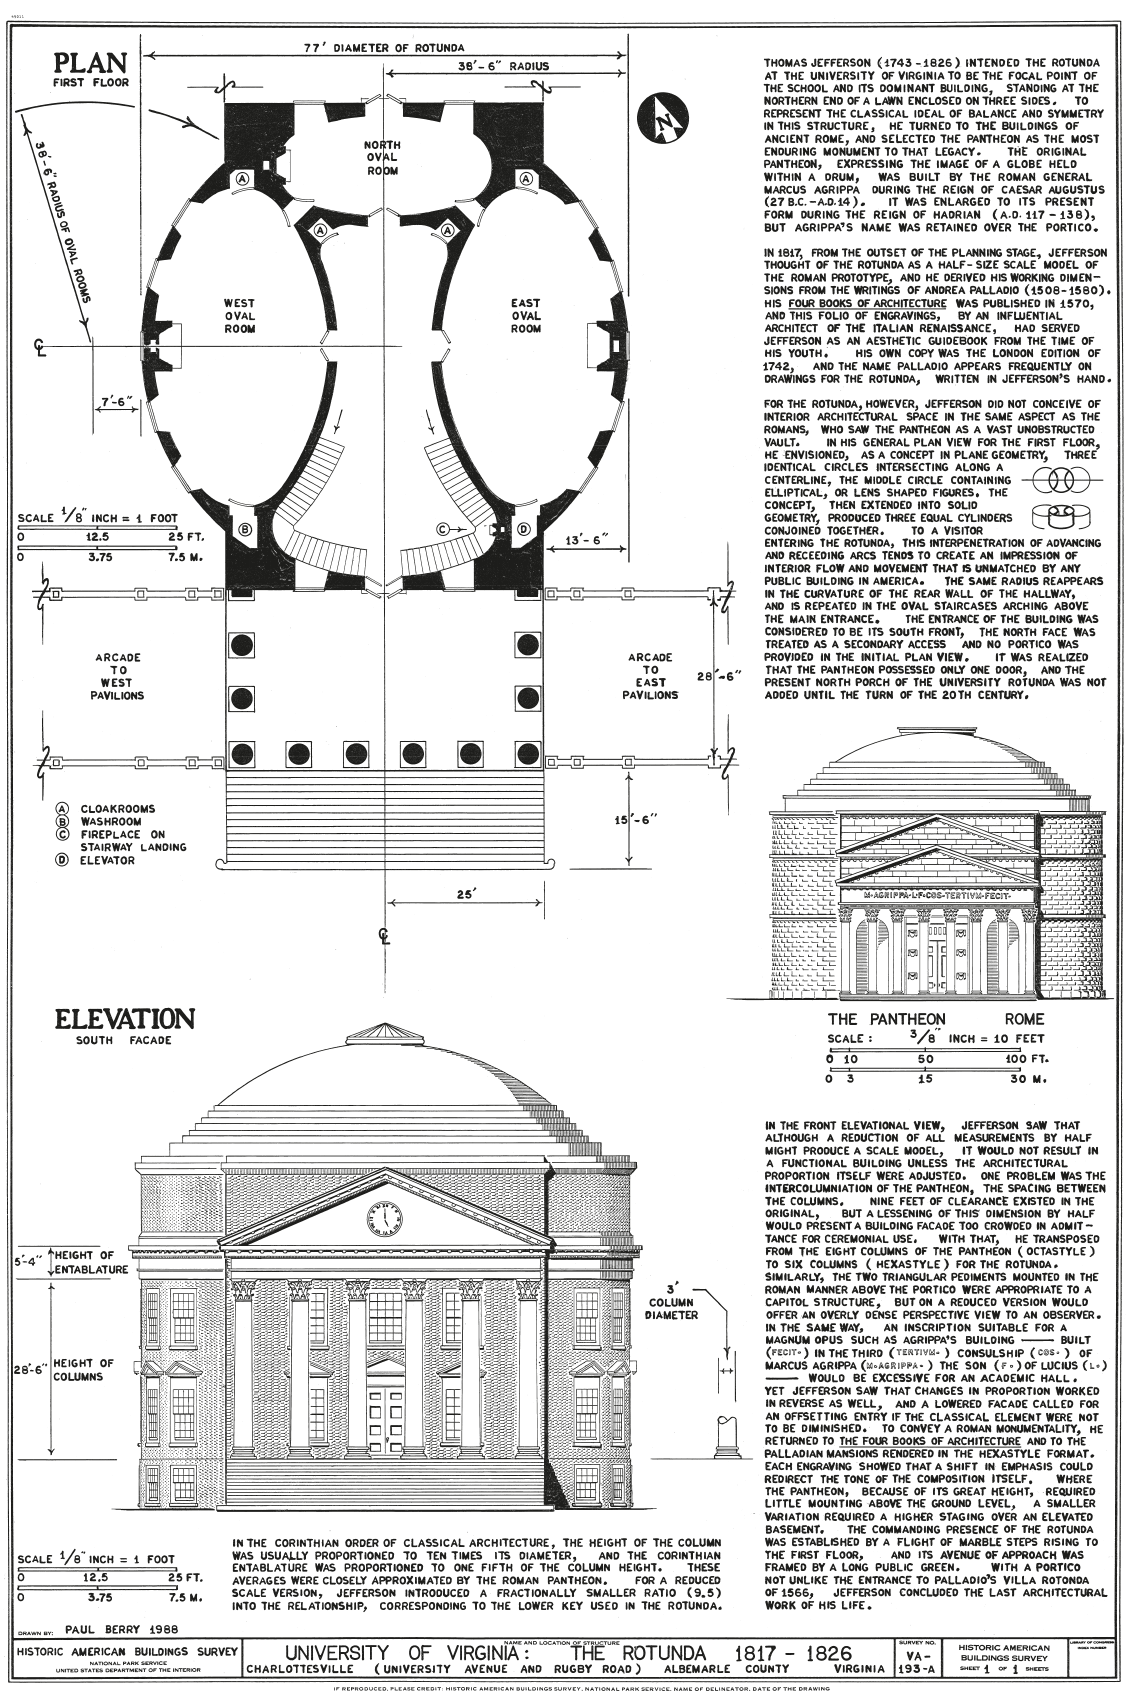
Figure 6 The Rotunda, University of Virginia, Charlottesville, Virginia (Source: Historic American Buildings Survey, US Library of Congress, Washington, DC)